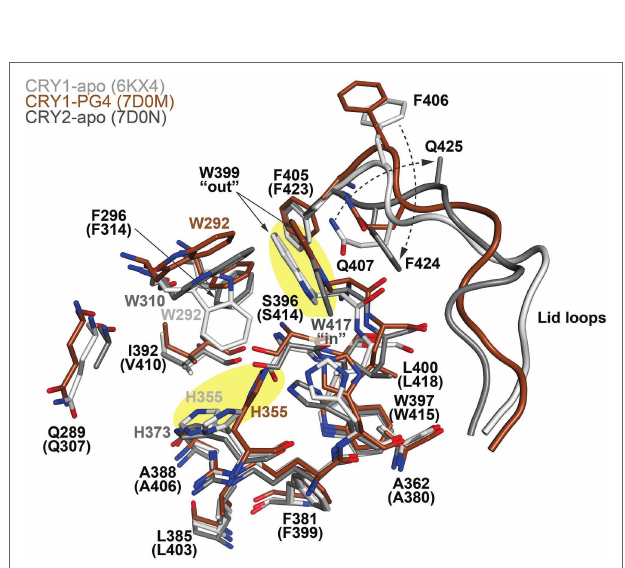
FIGURE 4 | Conserved residues in the FAD pockets and lid loops of CRY1 and CRY2 intrinsically adopt distinct conformations. Superposition of CRY1- apo (PDB ID: 6KX4; white), CRY1-PG4 (7D0M; brown; PG4 molecule not shown) and CRY2-apo (7D0N, gray) shows heterogeneity in the conformations of the FAD pocket residues CRY1 H355 and W399 (yellow shading), and the lid loop residues F406 and Q407 (CRY2 H373, W417, F424, and Q425, respectively). The opposite conformations of the CRY1 W399 and CRY2 W417 gatekeepers form differential interactions with reversed lid loop conformations (indicated by dotted arrows). CRY1 W292 displays some flexibility in CRY1 structures and occupied a “down” conformation in CRY1-apo (6KX4), but is repositioned to accommodate compounds ( Figures 5 – 7